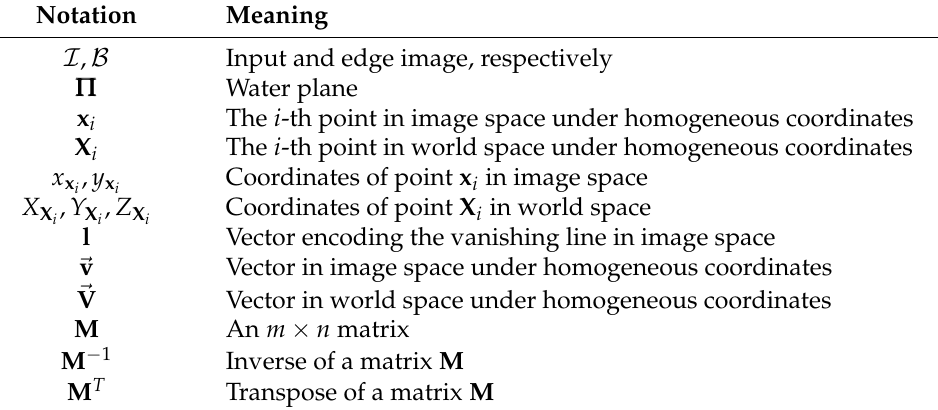
Figure 1. The pipeline followed to estimate the vessel speed. We intentionally flipped the rectified region of interest (ROI) image to make the vessel travel to the left. Table 1. Notation convention that is used in this